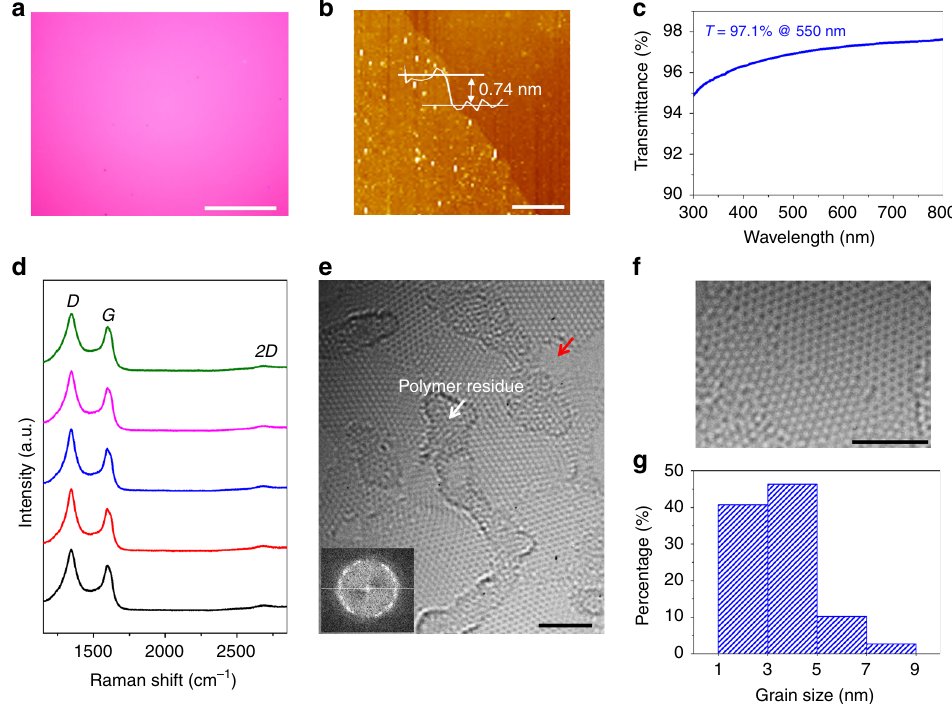
Fig. 4 Characterizations of the 3.6 nm-grained NG fi lm. a Optical image. b AFM image. The white dots are the contaminations left after transfer. c Optical transmittance spectrum measured by UV – vis-NIR spectrometer. d Raman spectra taken from randomly selected fi ve positions in a . e Typical HRTEM image. Inset, Fourier transform pattern. To expose the GBs, the samples were annealed at 320 °C in air for 8 h to remove the adsorbed PMMA residues, which simultaneously generates some holes as denoted by red arrow. f Atomic structure of a region containing a GB. g The histogram of the grain size extracted from HRTEM measurements. Scale bars: a 50 μ m; b 2 μ m; e , f 2